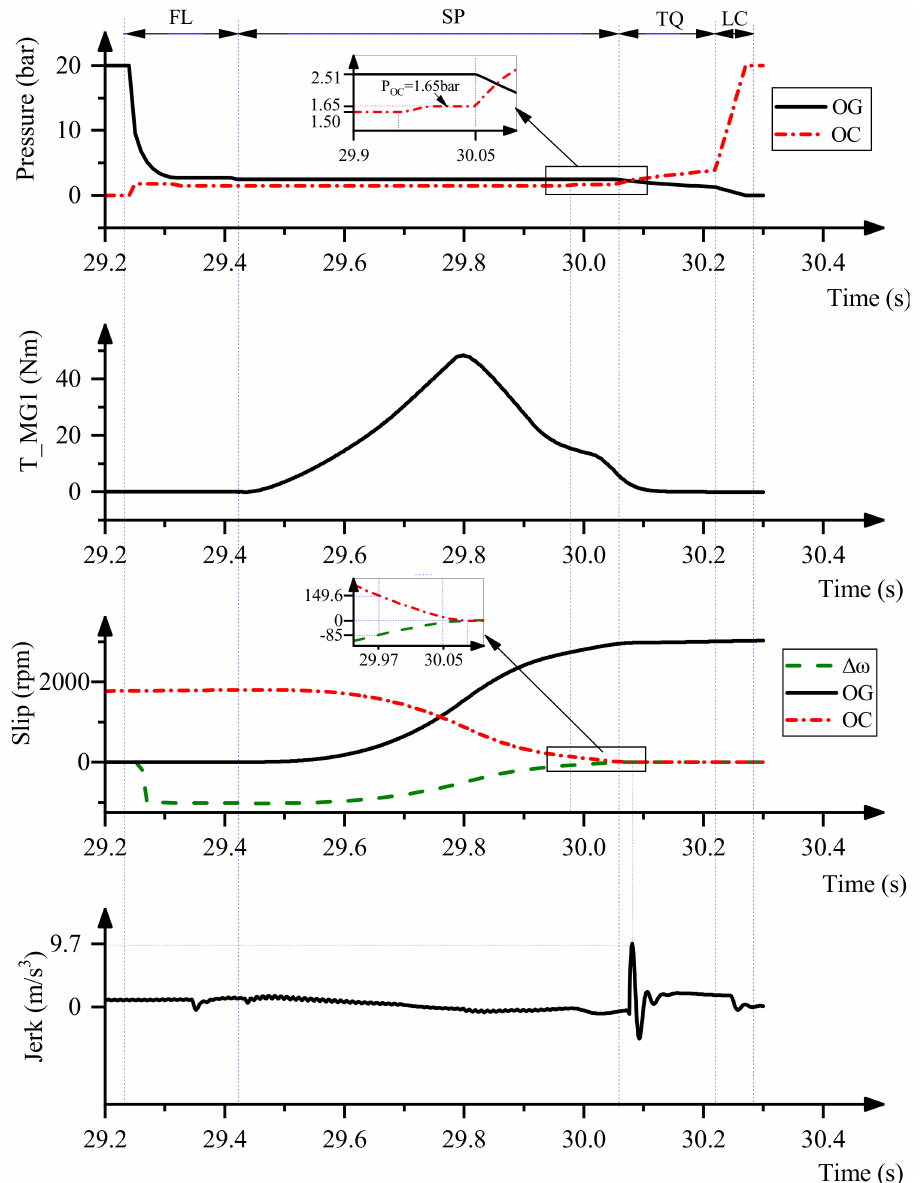
Figure 13. Simulation results of the shifting process with strategy 2. The control effects of two shifting processes with and without strategy 2 under the same control pressure of the OC clutch are compared in Figure 14. It can be seen that, as the OC control pressure is increased in advance, the slip delay phenomenon disappears, the reverse torque that is generated in the process of eliminating the remaining slip is significantly suppressed, and the corresponding fluctuation of the wheel output torque is also significantly reduced, so that the impact here is reduced from 36.6 m/s 3 to 9.7 m/s 3 , and the optimization effect of strategy 2 is obvious. In addition, the end time of the speed phase is also earlier than that without strategy 2, which means that the speed regulation time is shortened so that the shift time of the whole shifting process is